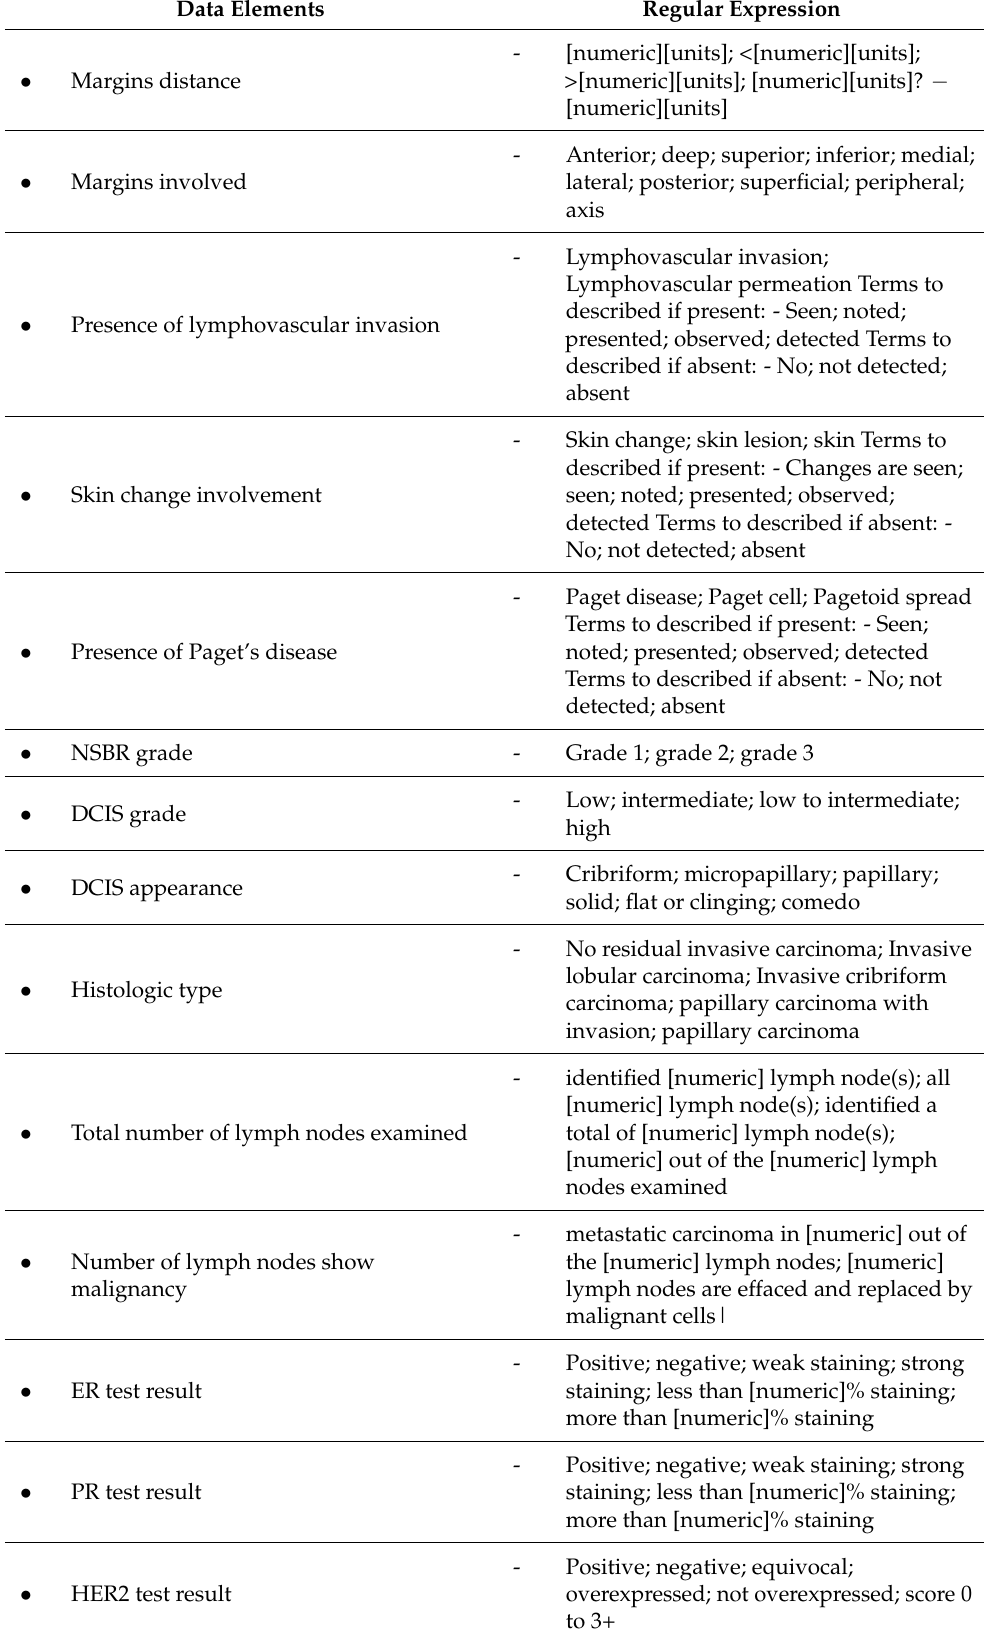
Table 2. Cont. Data Elements Regular